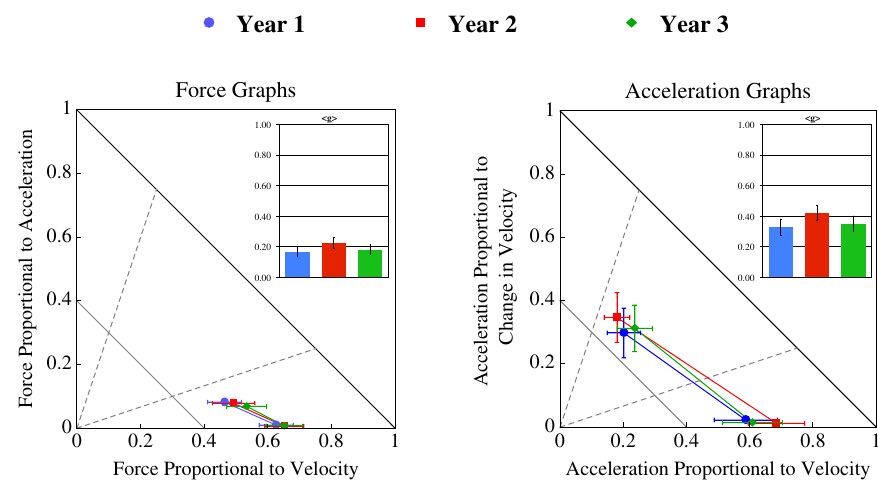
FIG. 8. Additional model analysis plots of FMCE data from school